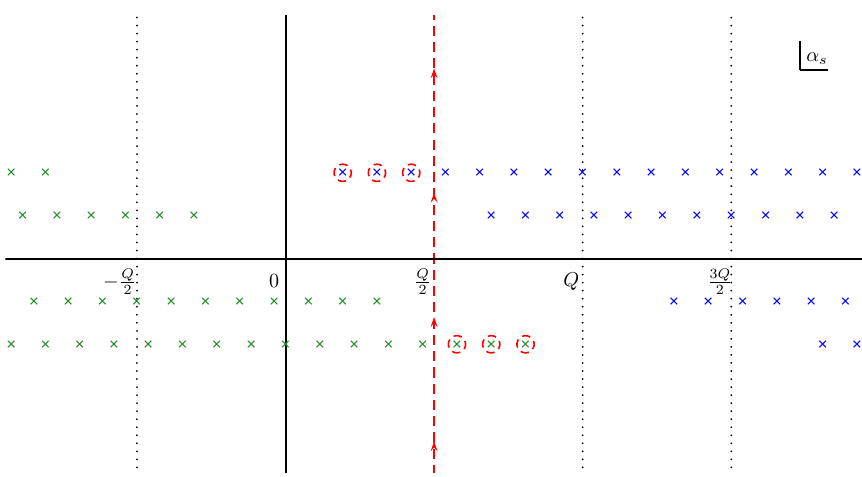
Figure 3 . For su(cid:14)ciently heavy external pairwise identical operators (Re( (cid:11) fusion kernel has four semi-in(cid:12)nite lines of poles extending in either direction. In the case of vacuum exchange in the T-channel, these poles are simple, otherwise they are double poles. Here we show an example of this in the case that all external operators have weights in the continuum, with 0 < b < 1. The dashed red curve denotes the contour of integration in the decomposition of the T-channel Virasoro block into S-channel blocks, while the blue and green crosses denote the poles of the fusion kernel.